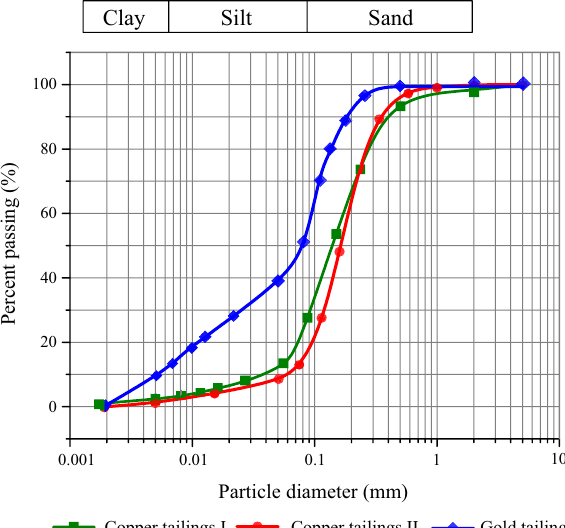
Figure 2. Particle size distributions of original tailings.